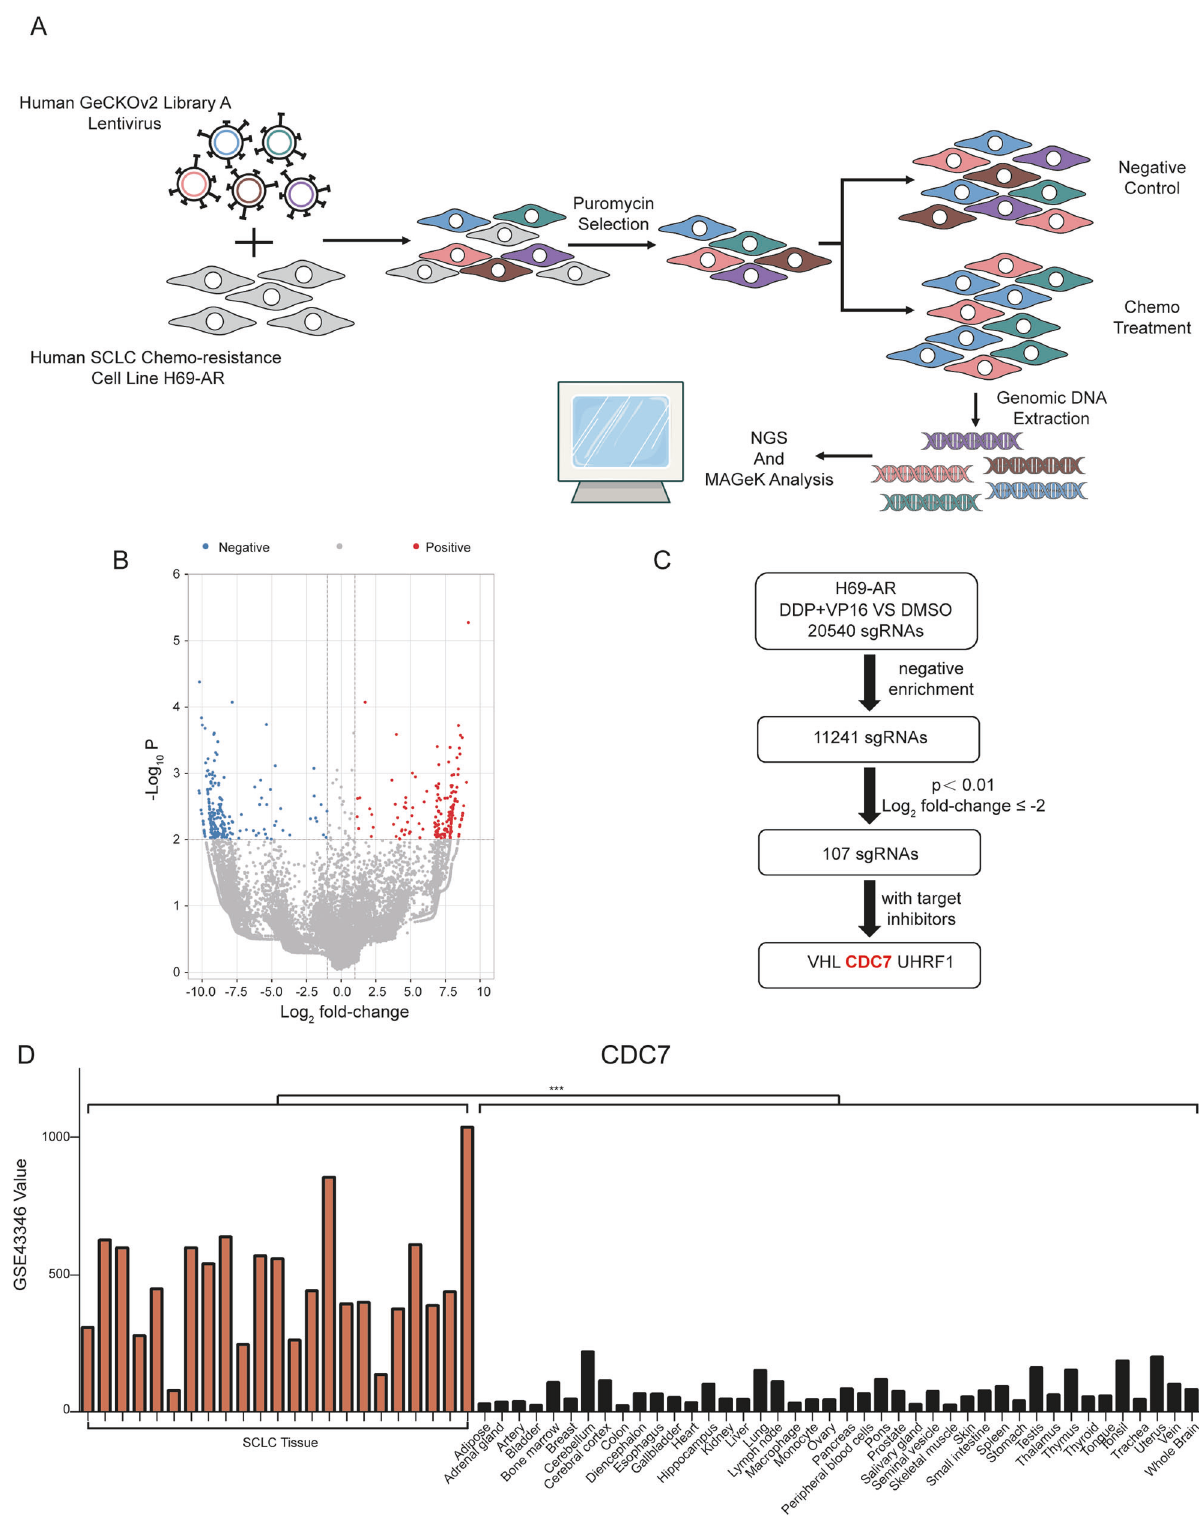
Fig. 1 CRISPR/Cas9 screening identi fi es CDC7 as a potential synergistic target for chemo-resistant SCLC. A Schematic of the screening process using resistant SCLC cells H69-AR with GeCKOv2 library. B Volcano plot of differentially enriched sgRNAs between negative treatment and chemo-treatment. C Work fl ow of potential synergistic targets identi fi cation. D Expression of CDC7 in SCLC and normal tissues from GSE43346. Independent sample t-test were used to examine statistical signi fi cance. * p < 0.05, ** p < 0.01, *** p < 0.001.